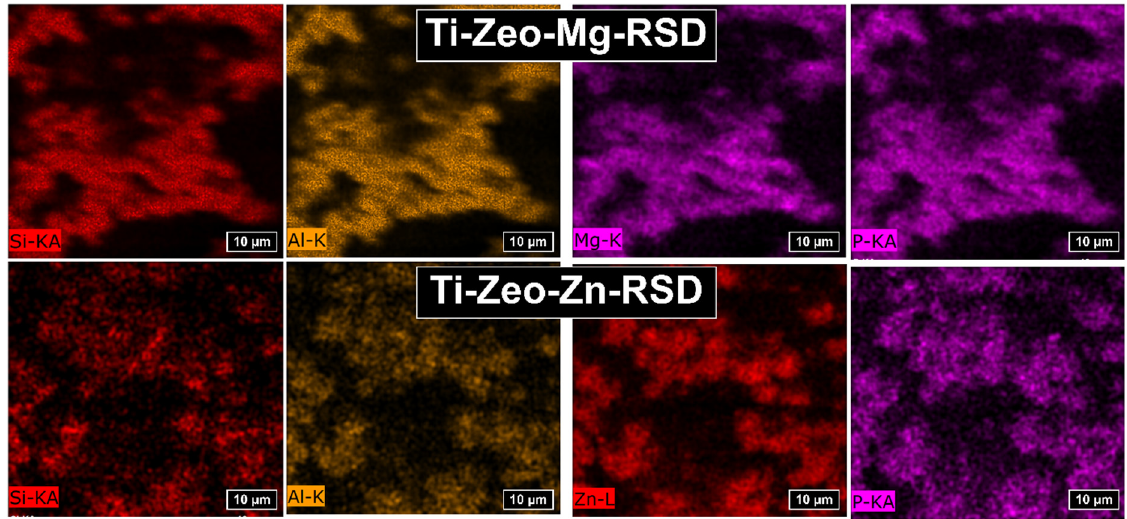
Figure 3. Distribution of ions in the synthesized layers.